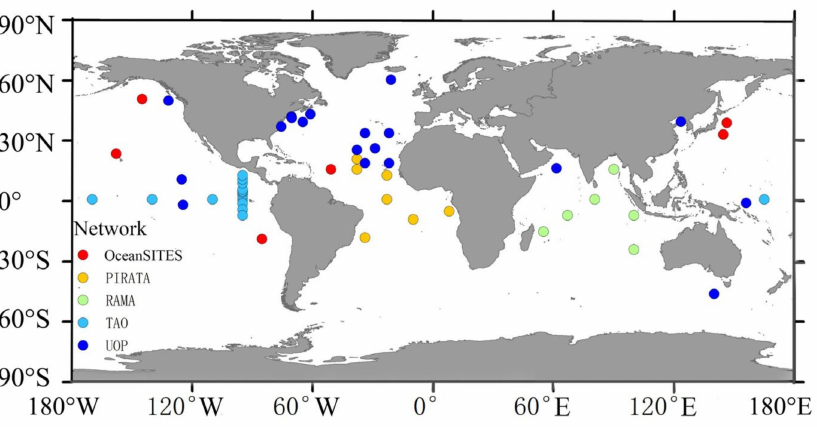
Figure 1. Distribution of 55 moored buoy sites in five measuring networks. According to the locations of the 55 moored buoy sites, the J-OFURO3 daily sea- surface R n data, which were calculated by combining the J-OFURO3 daily R ns and R nl values directly, were extracted from 1988 to 2013 and processed into a monthly scale. The sea-surface R n data in J-OFURO3 were obtained with a spatial resolution of 0.25 ◦ from 1988 to 2013 at daily and monthly scales and then extracted according to the locations of the 55 buoy sites. Moreover, sea-surface R n data were derived from four popular reanalysis products and a ship-based product, the Japanese 55-Year Reanalysis (JRA55, 0.56 ◦ × 0.56 ◦ ) from the Japanese Meteorology Administration (JMA) [22], ERA5 (0.25 ◦ × 0.25 ◦ ) from the European Centre for Medium-Range Weather Forecasts (ECWMF) [23], the Modern Era Ret- rospective Analysis for Research and Applications, version 2 (MERRA2, 0.625 ◦ × 0.5 ◦ ) [24] from NASA’s Global Modeling Assimilation Office (GMAO), the third-generation, high- resolution version of the ISCCP radiative flux profile product named ISCCP-FH (1 ◦ × 1 ◦ , 1983–2017) [25], and the ship-based product NOCS v2.0 (1 ◦ × 1 ◦ , 1973–2014) by in situ observations from voluntary observing ships contained in the International Comprehensive Ocean–Atmosphere Data Set (ICOADS) [26], extracted at daily and monthly scales from 1988 to 2013, and used for comparison in this